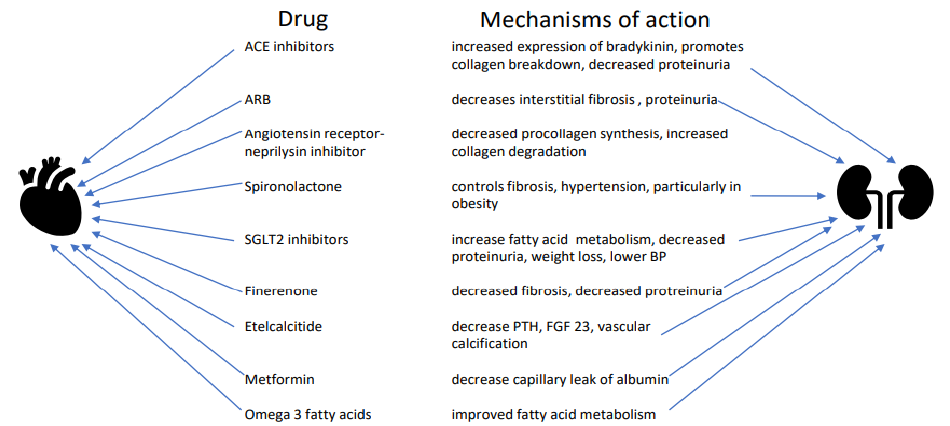
Figure 3. Drug actions in cardiorenal syndrome.